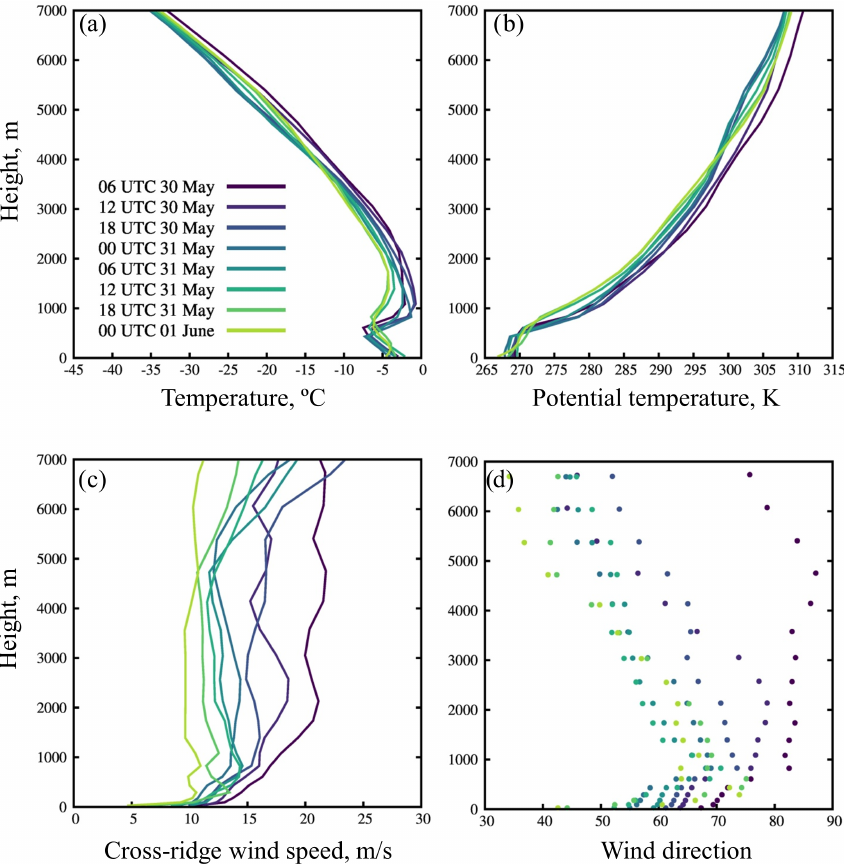
Figure B1. Vertical profiles of the incoming flow during the foehn episode according to WRF modeling: (a) air temperature, (b) potential temperature, (c) cross-ridge wind component and (d) wind